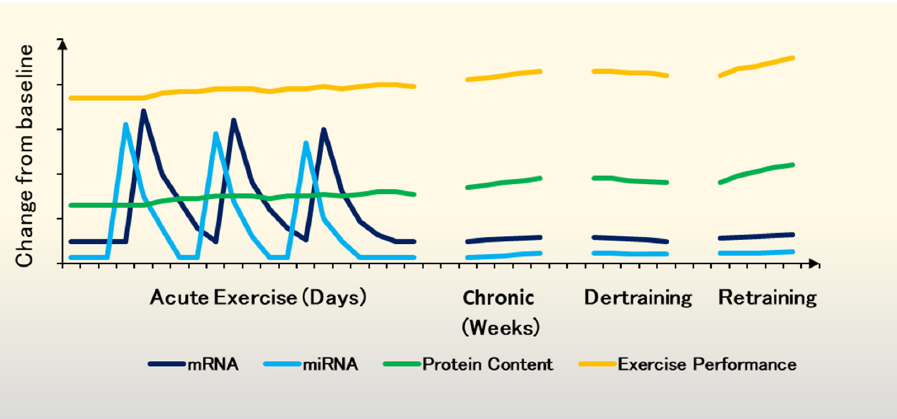
Figure 3. A revised model of the molecular basis of adaptation to exercise. Changes in mRNA expression (dark blue), miRNA (light blue) and protein content (green) due to acute and chronic exercise. Individual bouts of exercise are necessary for adaptation but insufficient to significantly alter the phenotype. Rapid bursts of mRNA during post-exercise recovery facilitate the expression of target genes. Alterations in mRNA expression several-fold from basal levels are typically greatest at 3–12 h after exercise and generally return to basal levels within 24 h. miRNA response follows a similar burst-like trajectory and miRNAs are thought to respond to changes in the environment quickly. The translational response is modest in comparison to mRNA and miRNAs. However, superimposing exercise bouts chronically results in the gradual accumulation of protein content contributing to enhanced exercise performance (orange). During a period of detraining, the baseline mRNA, miRNA and protein levels decrease steadily, but epigenetic changes decelerate the phenotypic decline. Initially, exercise performance does not suffer due to reduced residual fatigue (i.e., tapering). Upon return to training, people with longer exercise history achieve their previous phenotype at a faster rate than in the past or less trained individuals. This effect is likely due to the miRNA-dependent establishment or enhancement of the pro-adaptive epigenetic profile (model revised based on [39,163].